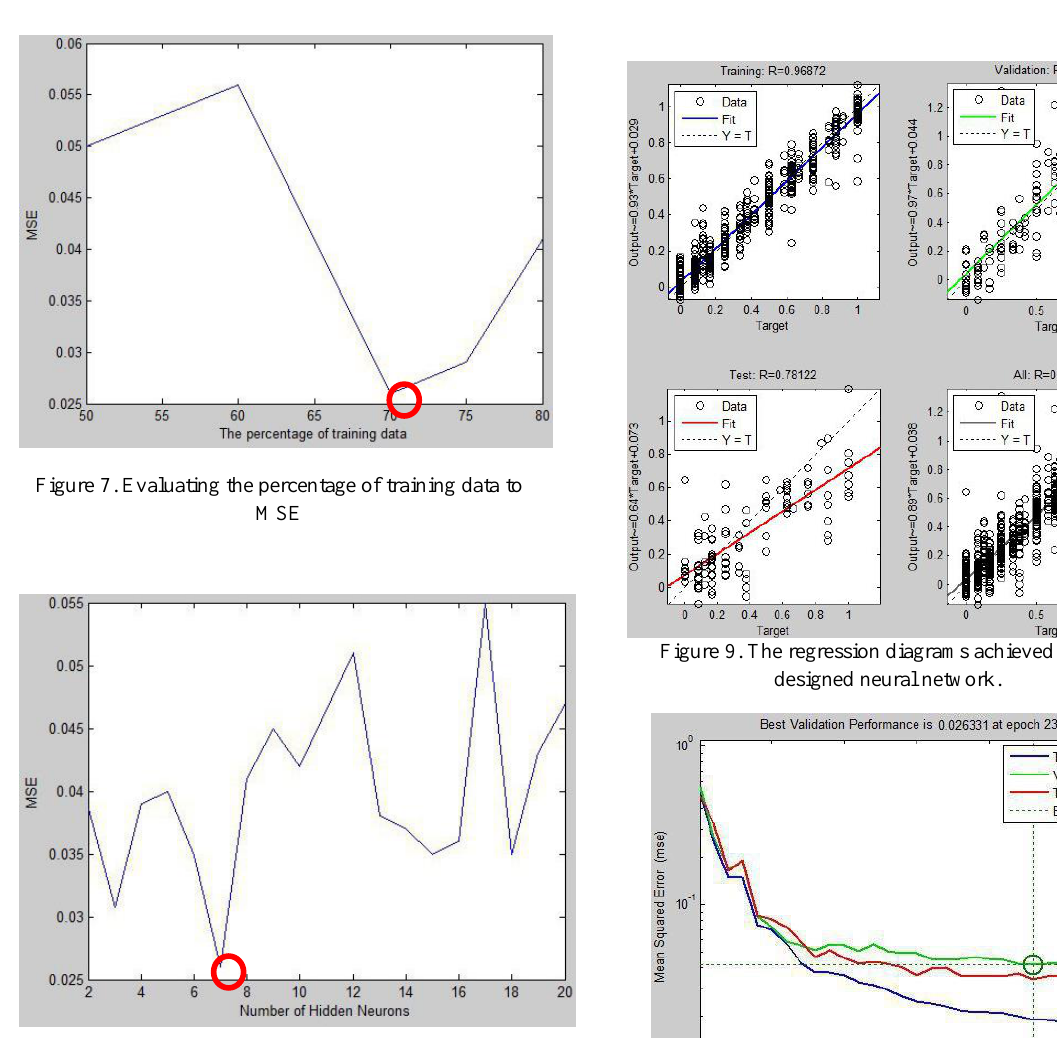
In Figure 9, the regression diagrams achieved by the designed neural network are shown and in Figure 10 the performance (MSE) of the proposed neural network for this Levenberg-Marquardt training phase is shown.